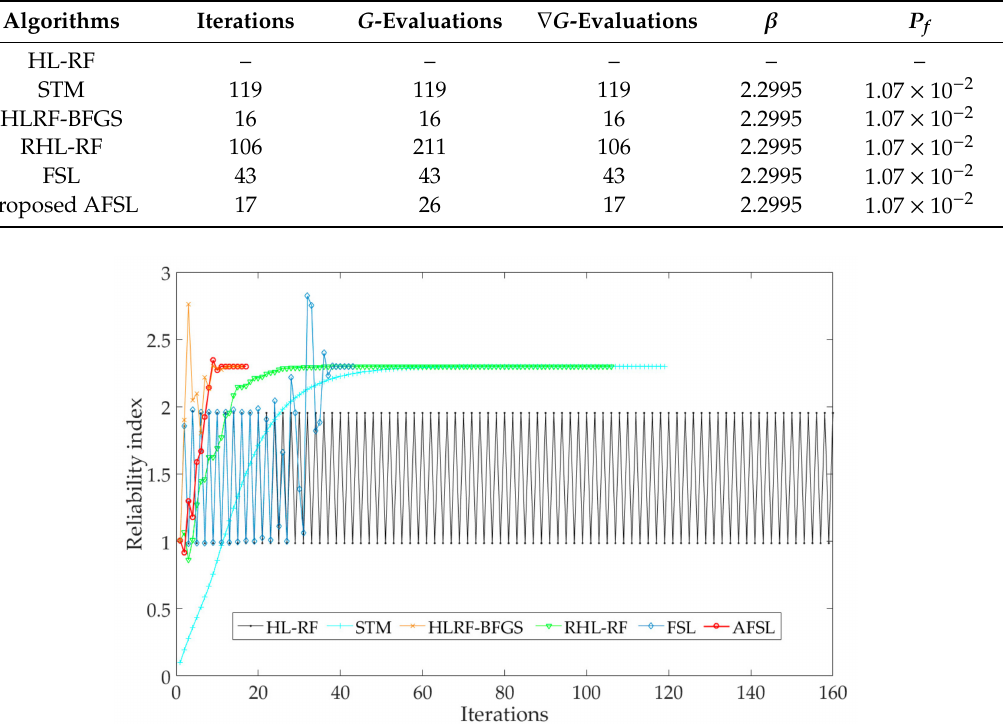
Table 2. Results of di ff erent algorithms for Example 2.